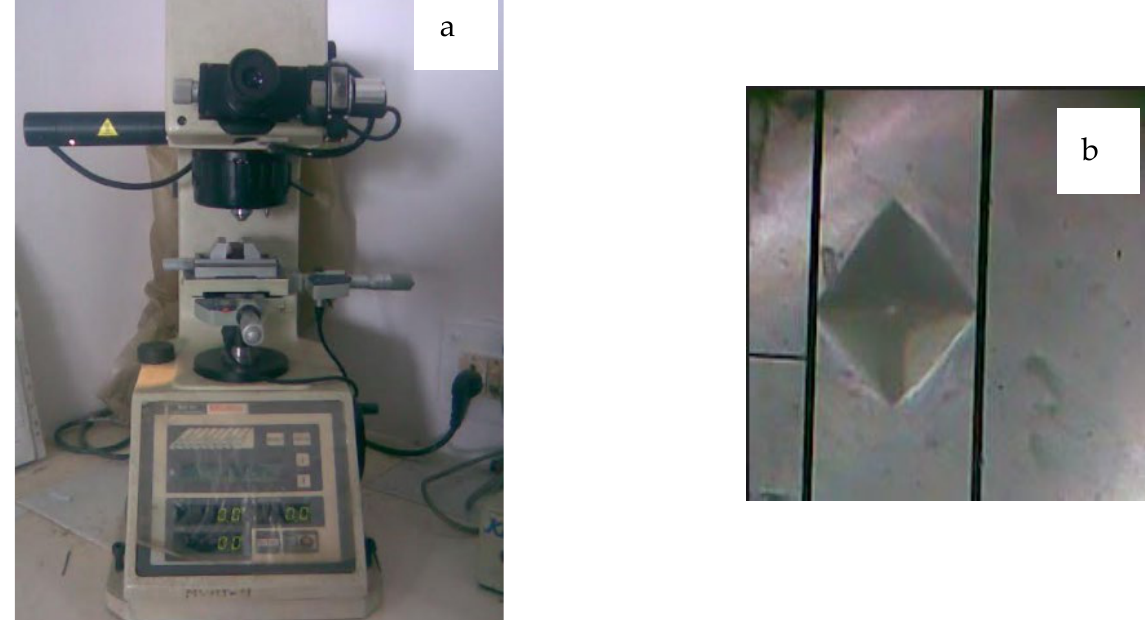
Figure 9. ( a ) Digital Micro-hardness Tester ( b ) Image of indent for micro-hardness analysis.